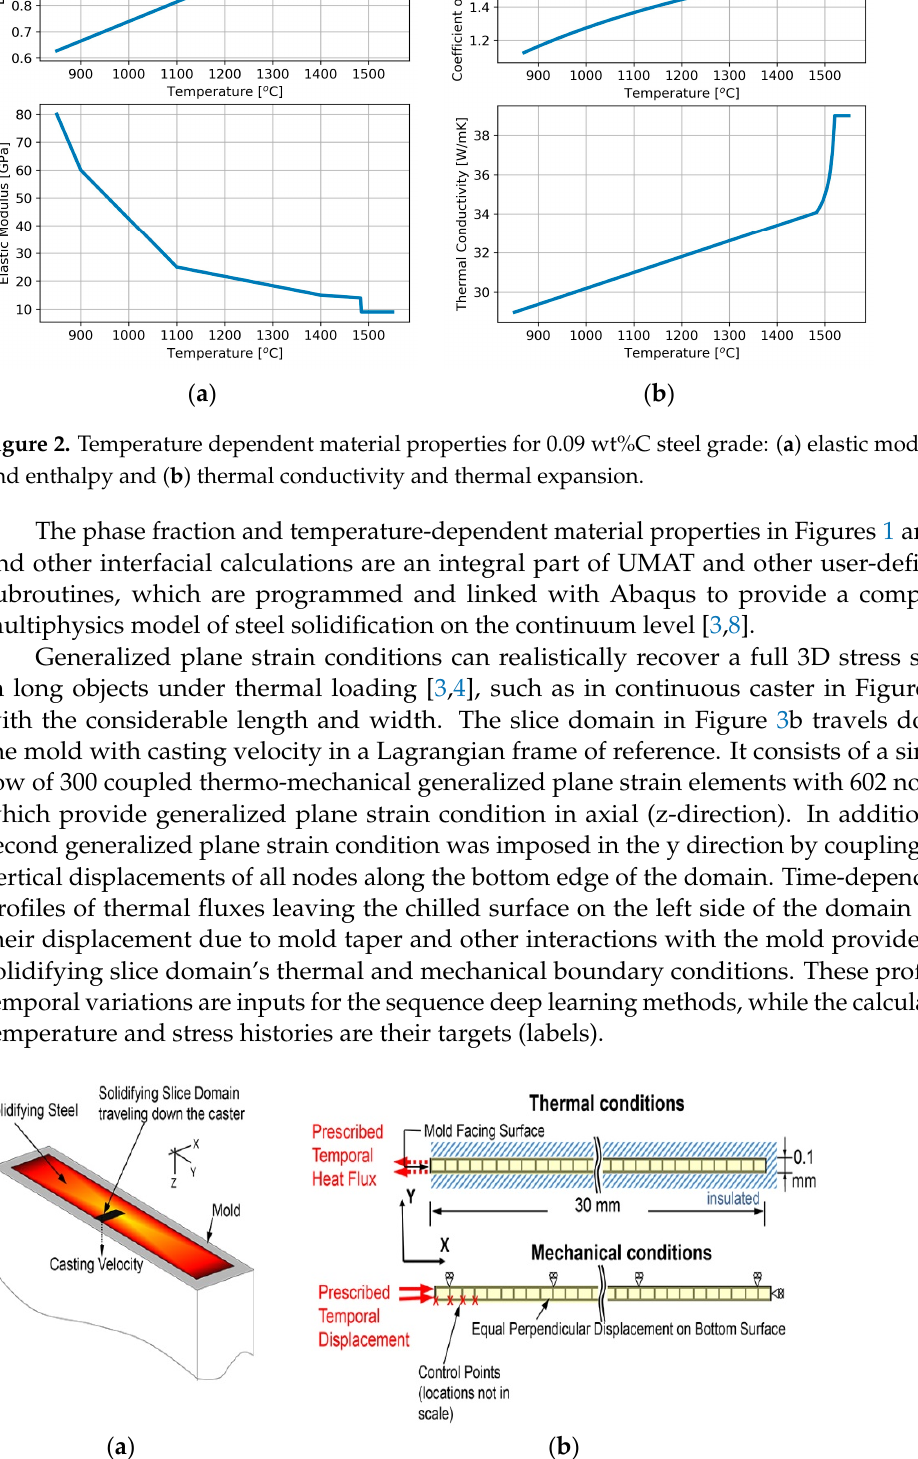
Figure 3. ( a ) Continuous caster with solidifying slice finite element domain and ( b ) thermal and mechanical boundary conditions.